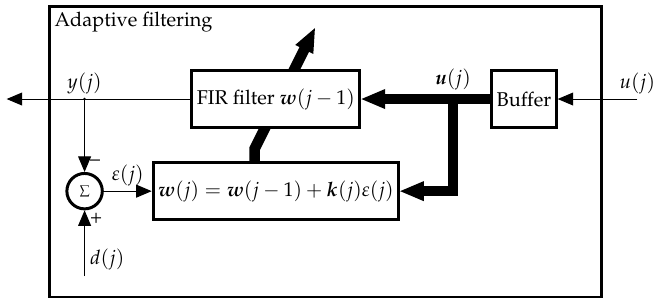
Figure 3. Block diagram of the RLS adaptive filter